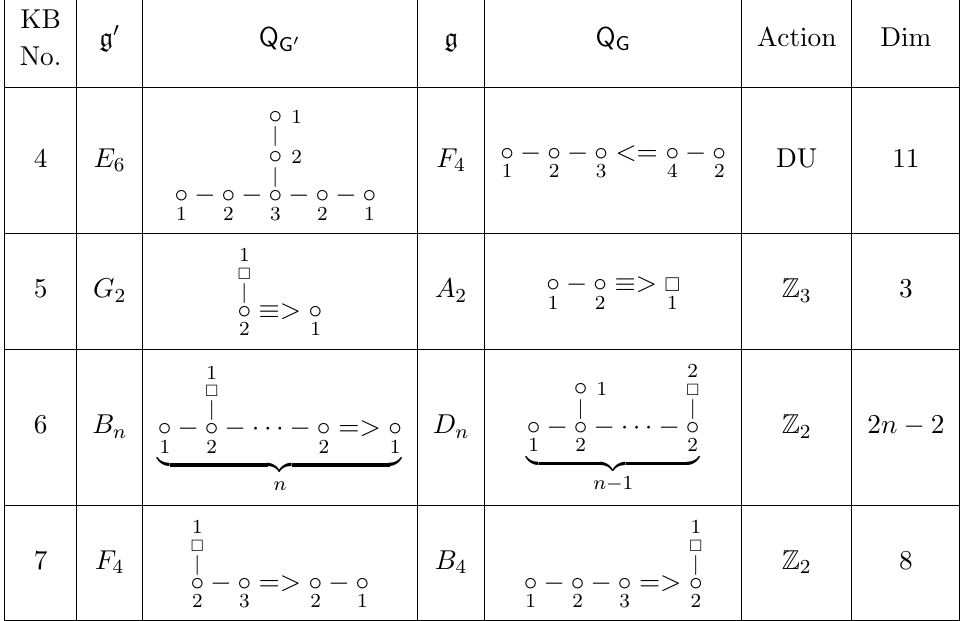
Table 1 . Results 4, 5, 6, and 7 of table 1 in [1], corresponding Coulomb branch quivers, actions and dimensions. Round and square nodes denote gauge and (cid:13)avor groups, respectively. DU denotes an action on quivers termed discrete ungauging which is studied in